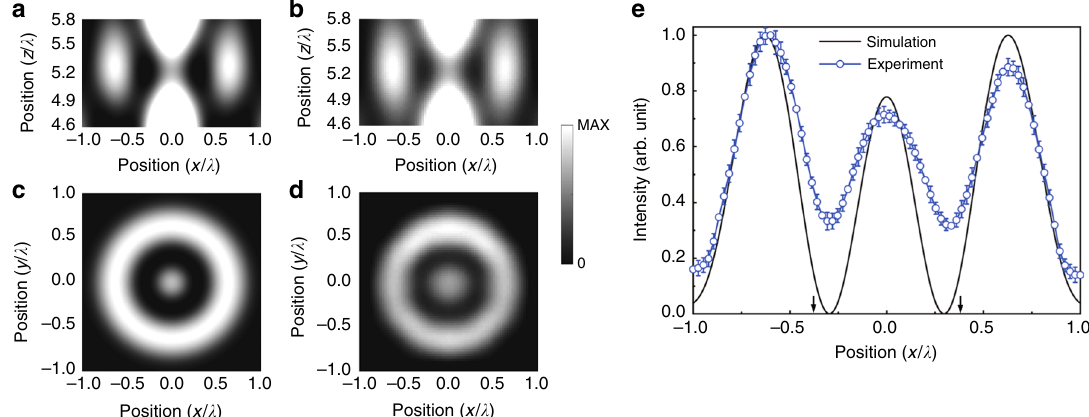
Fig. 3 Super-oscillation packet in the ultrasonic meta-lens. a , b The simulated and measured intensity distributions of a super-oscillatory ultrasound fi eld on the x - z plane. c , d The simulated and measured intensity distributions of the super-oscillation packet in the fi eld of view (2 λ ´ 2 λ ) on the x - y plane at z ¼ 5 : 2 λ . e The simulated and measured intensity distributions along the line at x ¼ ½(cid:3) λ ; λ (cid:6) , y ¼ 0, z ¼ 5 : 2 λ . The ultrasound frequency is 1 MHz. In a – e , the data are normalized with respect to the maximum. The bottom arrows in e indicate the location of the diffraction limit (0 : 38 λ ). The experimental error bar is de fi ned by the standard deviation of sound intensity measured in ten